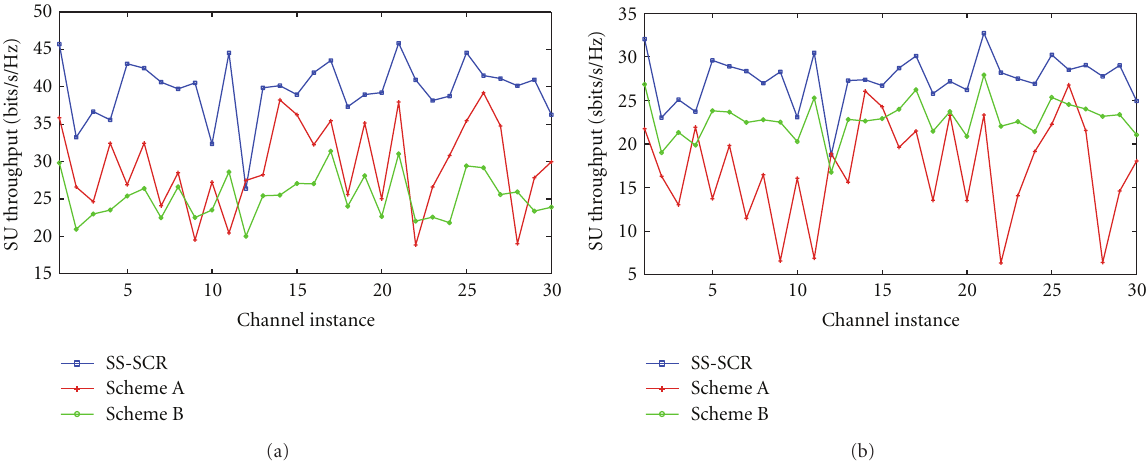
Figure 7: SU throughput versus channel instance (exponential): (a) high mean OFF time, (b) high mean ON time.